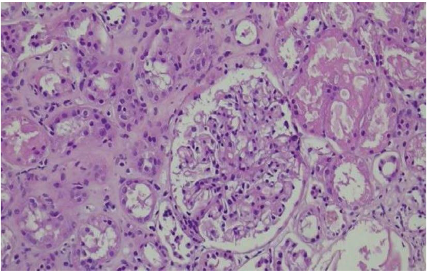
Figure 3: Slight enlargement of the glomerular tufts of hema- toxylin cosine × 200 and slight thickening of the basement mem- brane are